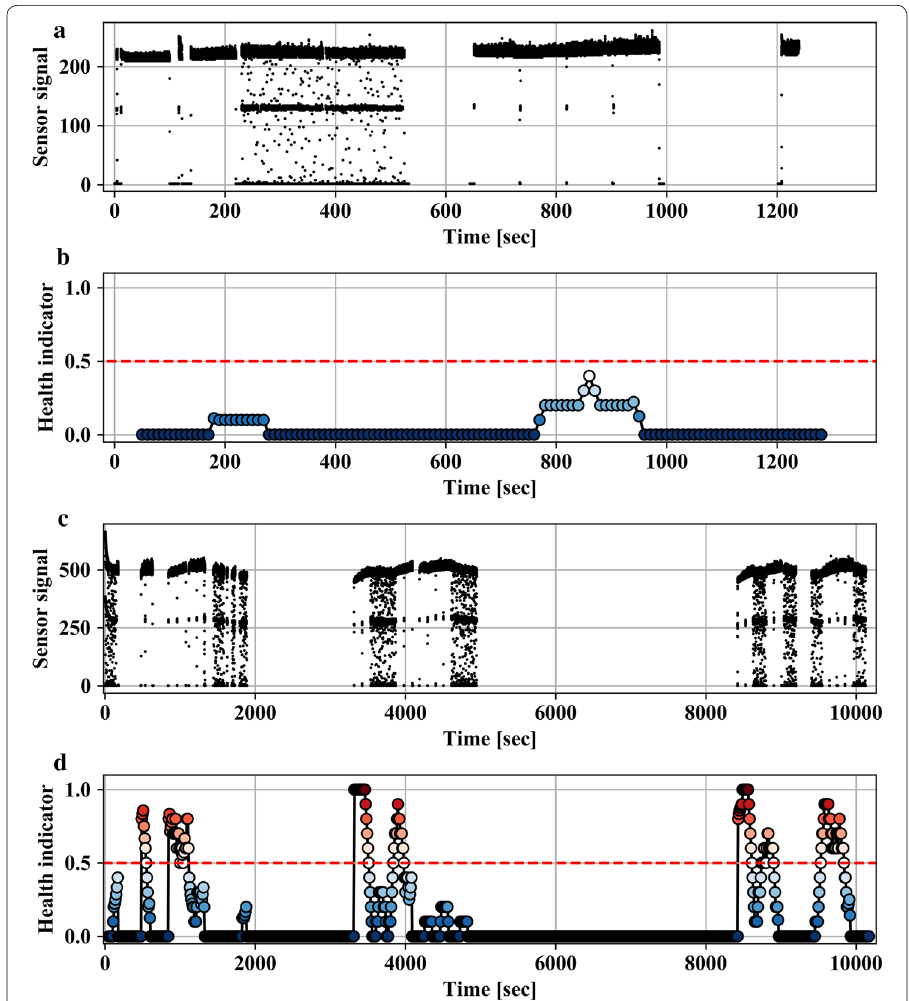
Fig. 9 Fault detection using statistical analysis. a Sensor signal of healthy machine. b Health indicator for healthy machine. c Sensor signal for faulty machine. d Health indicator for faulty machine. Red dashed line indicates the detection